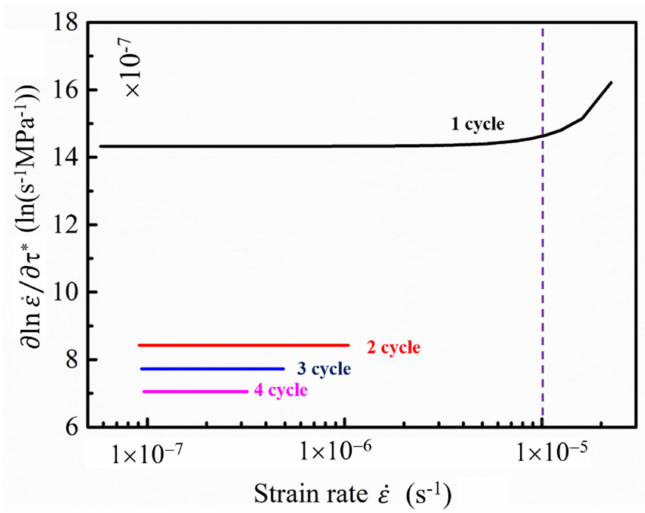
. . ε / ∂τ * vs. ln ε curves at each stress relaxation